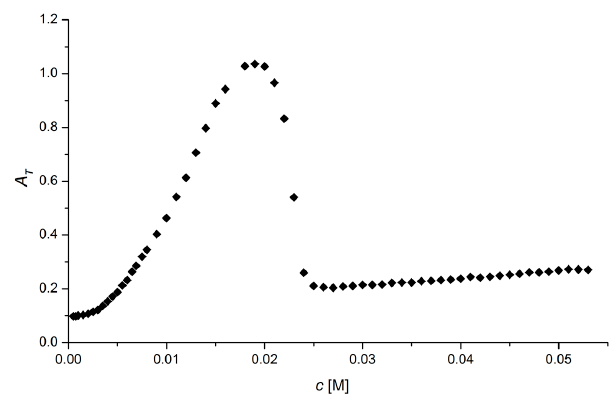
Figure 3. A T of main pyrene peaks at 336 and 320 nm vs. concentration ( c ) profile for compound 5 in aqueous medium at 25 °C in whole measured concentration range.